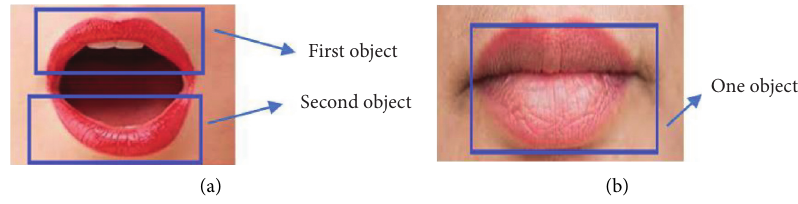
Figure 7: Mouth detection. (a) Open mouth. (b) Close